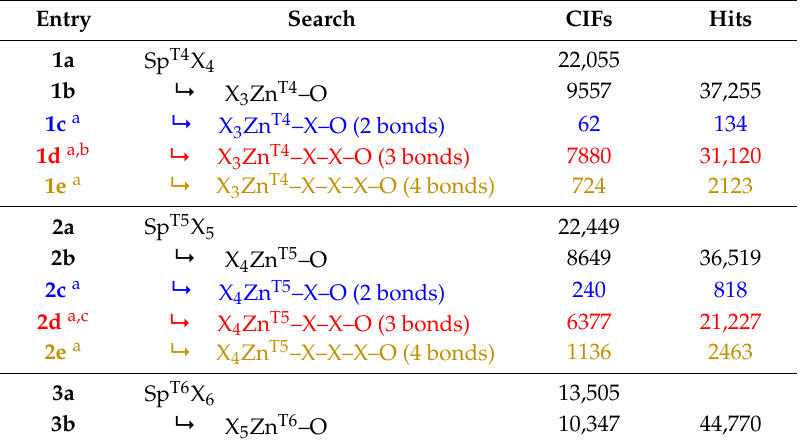
Table 3. Numerical overview of CSD data. Sp = Zn, Cd or Hg, X = any atom, all bonds could be any type of bond.